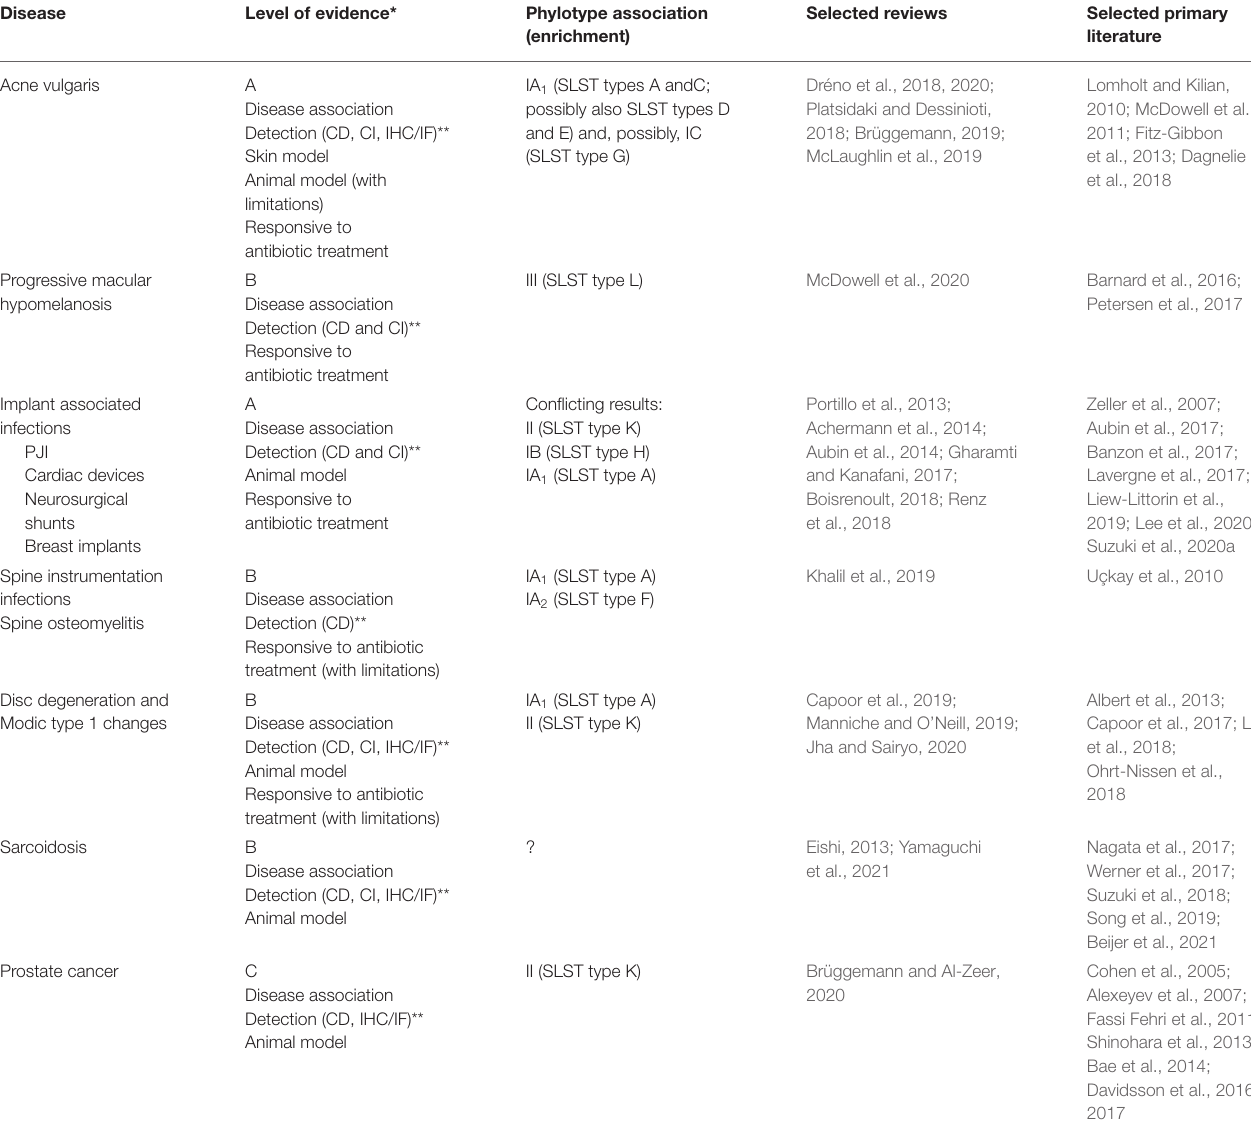
TABLE 1 | Disease associations of C. acnes and evaluation of the existing evidence.